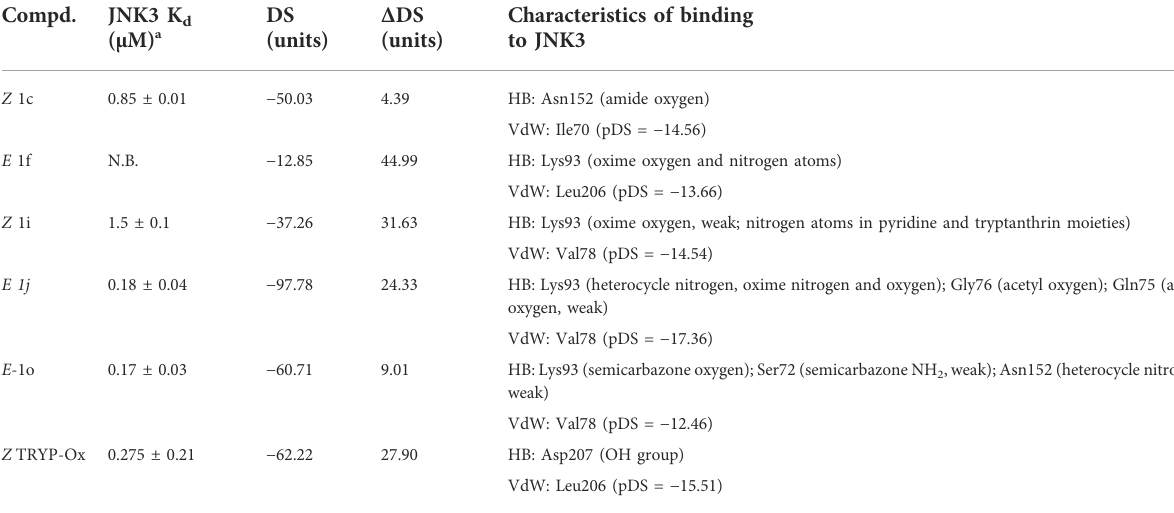
TABLE 2 MVD docking scores (DS) for the best docking poses, absolute differences Δ DS between Z and E isomers, and key interactions with the binding site of JNK3 (PDB: 1PMV) for compounds 1c, 1f, 1i, 1o, 1j, and TRYP-Ox. Compd.